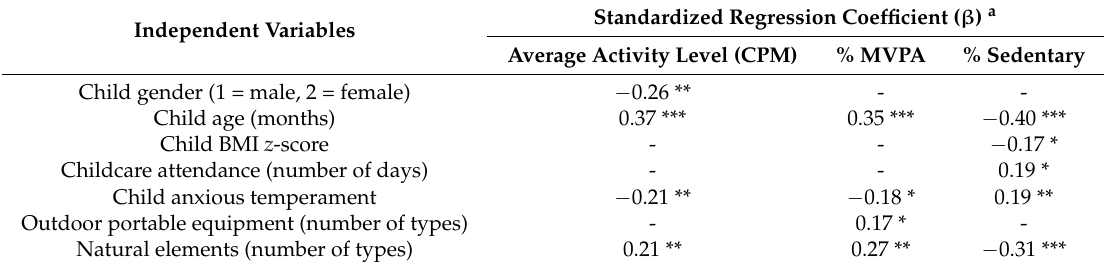
Table 3. Backward multivariate regression analyses of the association between the physical childcare environment, children’s characteristics, and children’s PA levels ( N = 152). Standardized Regression Coefficient ( β ) a Independent Variables Average Activity Level (CPM) %